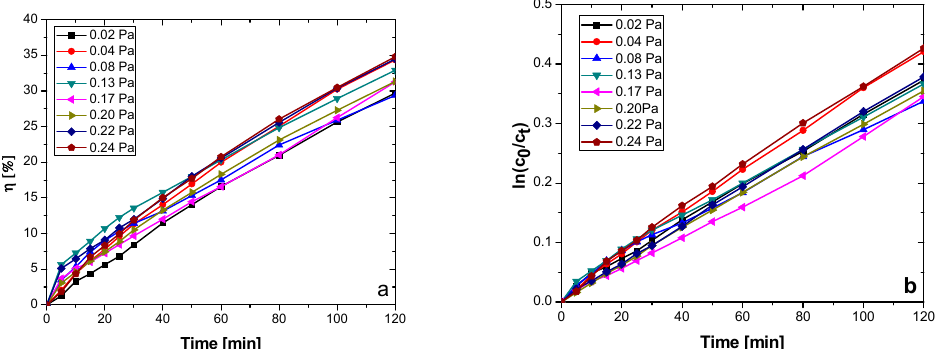
Figure 12. ( a ) Photodegradation efficiencies of the tantalum oxynitride samples; ( b ) graphical determination of the reaction rate of the photocatalytic degradation of MB.